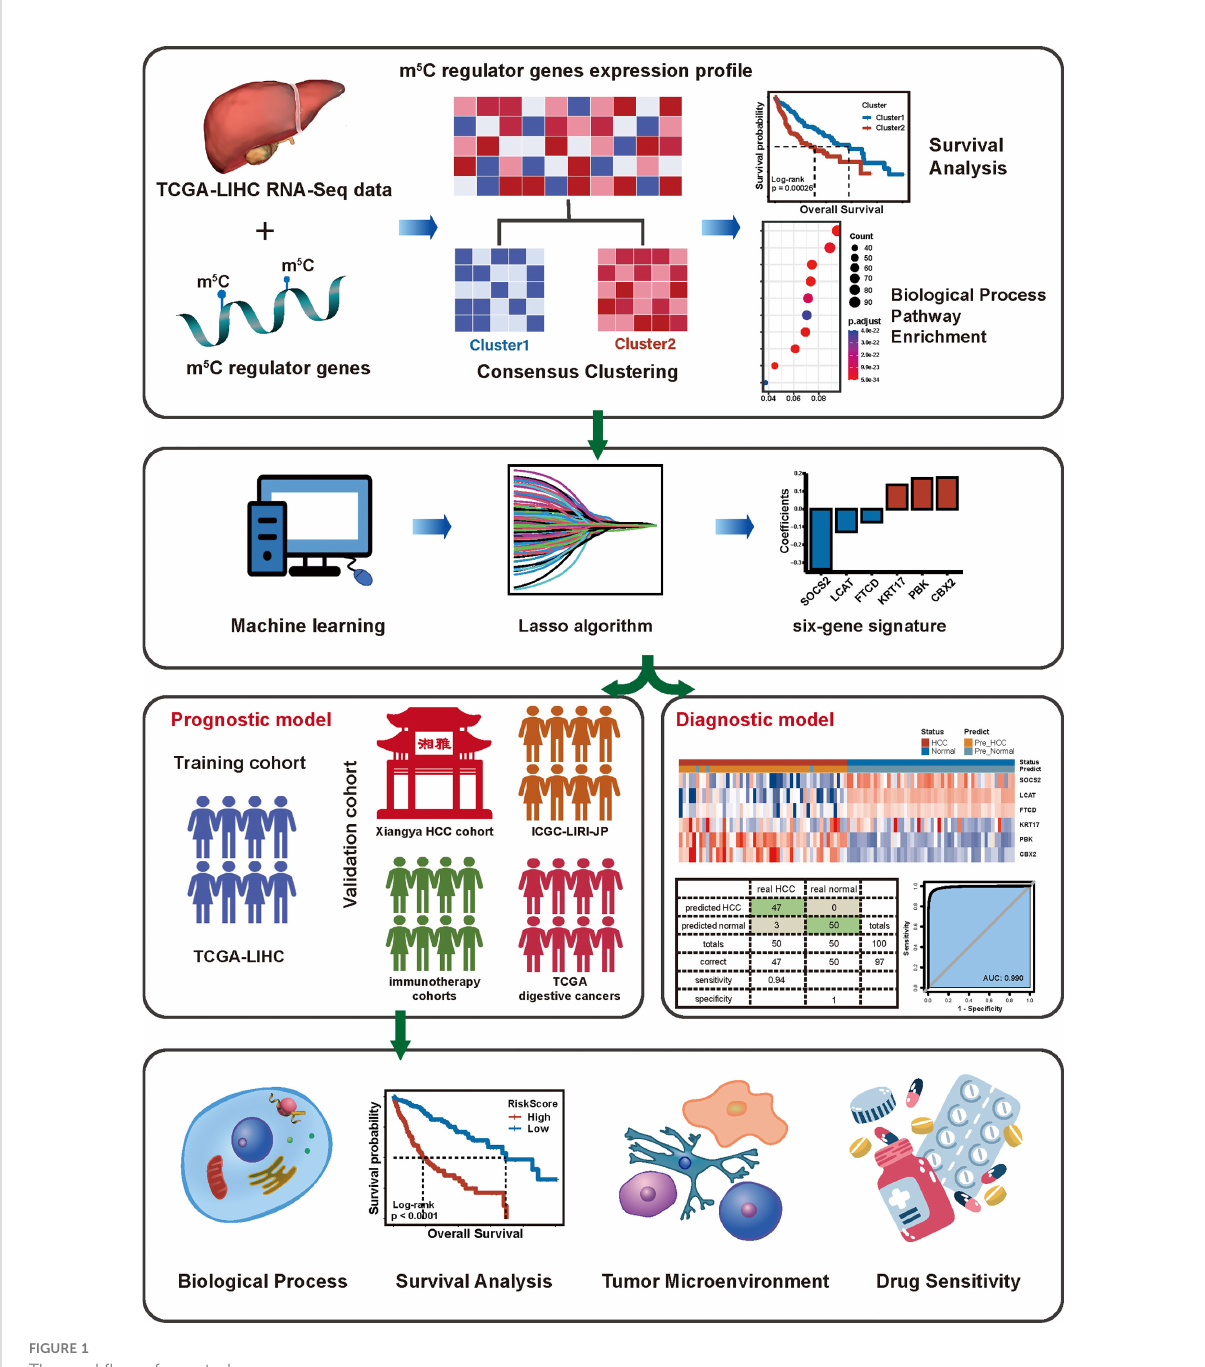
FIGURE 1 The work fl ow of our